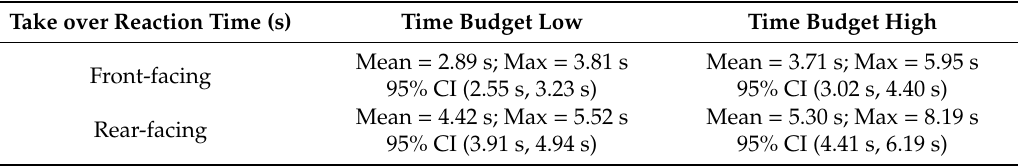
Table 1. Take-over reaction time results from different conditions.